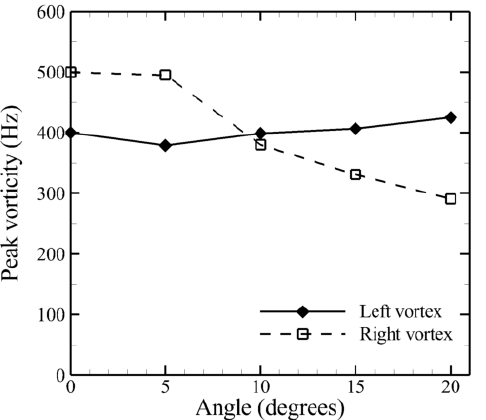
Figure 7. Peak vorticity at different angles of rotation of the front